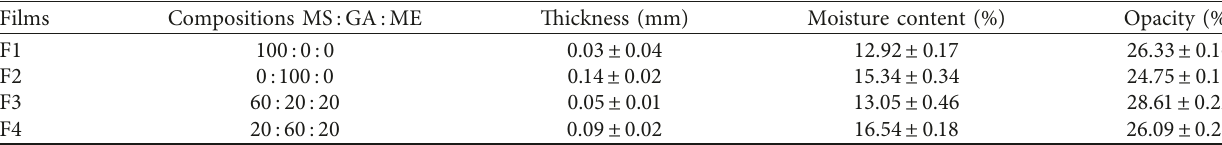
Table 1: Film thickness, moisture content, and opacity of the